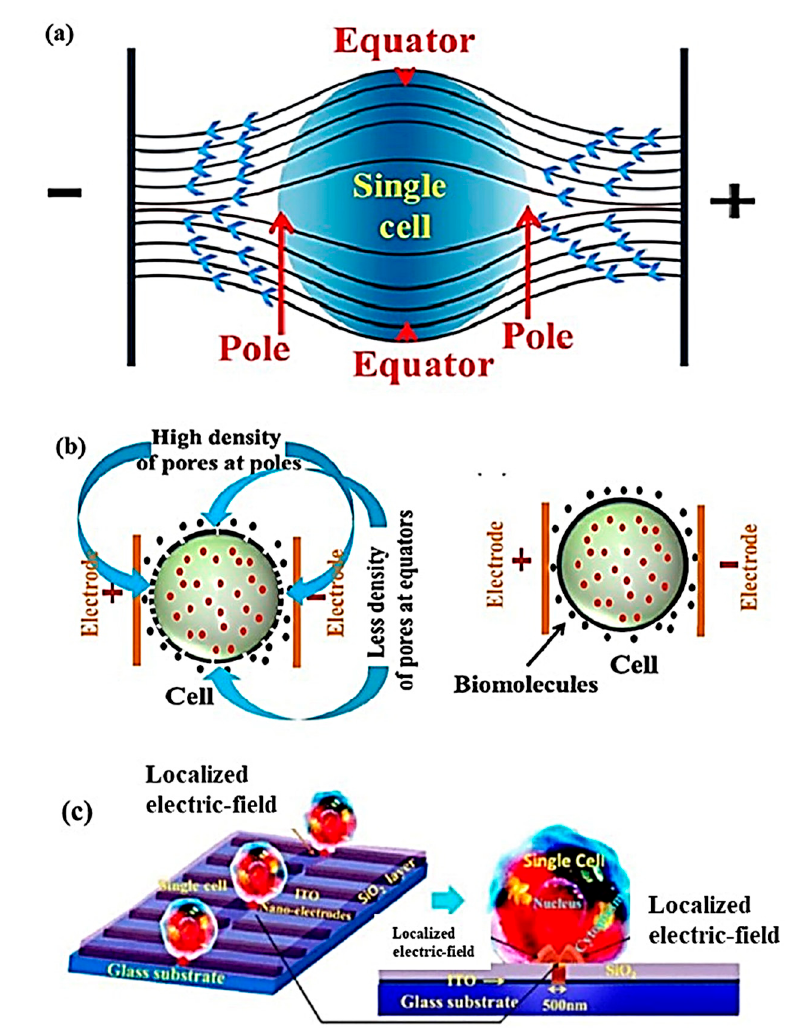
Figure 13. ( a ) Schematic showing distribution of electric field facilitating single-cell electroporation (SCEP); the induced transmembrane potential is found to be highest at the cell pole and decreases towards the equator. ( b ) Microfluidic SCEP with cell trapping. Reprinted with permission from [154]. ( c ) Localized SCEP with electric field ( b ) membrane area dependent density of pore formation and distribution due to non-uniform electric field application ( c ) nano-localized single-cell nano-electroporation. Reprinted with permission from [156].